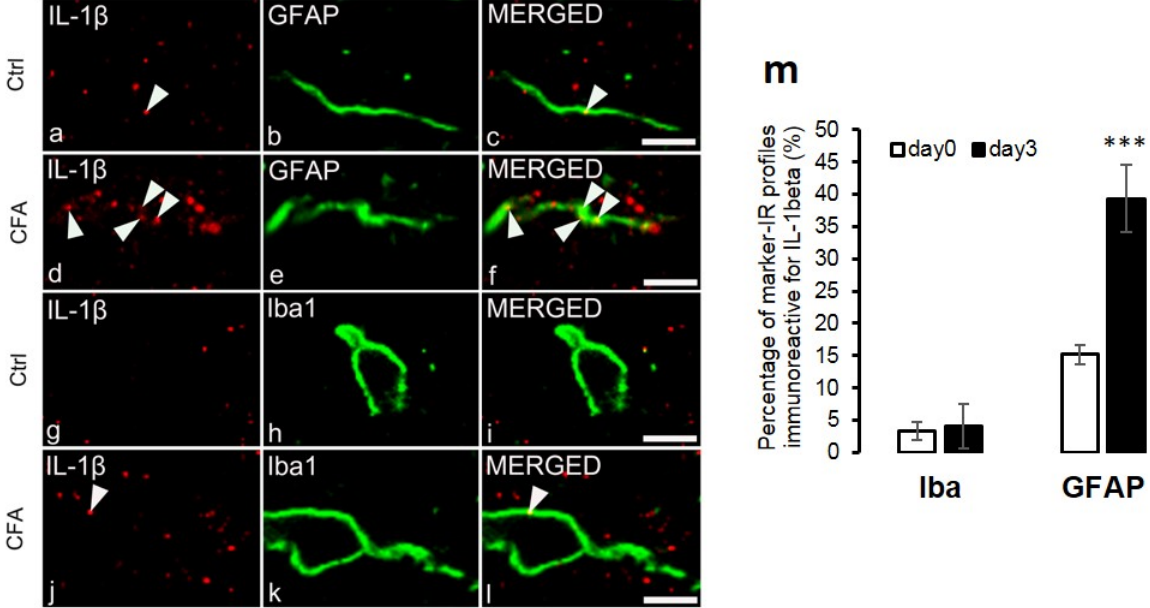
Figure 3. IL-1 β is dominantly expressed by spinal astrocytes on post-injection day 3, at the peak of CFA-evoked inflammatory pain. The figure shows the localization of IL-1 β on glial cells in the superficial spinal dorsal horn of rats. Micrographs of single 1 µ m thick laser scanning confocal optical sections illustrating the co-localization of IL-1 β + puncta (red) with astrocyte (GFAP, green) profiles in control conditions ( a – c ) and in CFA-induced inflammation ( d – f ). Co-localization of IL-1 β + puncta (red) with microglial profiles (Iba1, green) in control ( g – i ) and CFA-induced inflammatory ( j – l ) conditions. Arrowheads on images indicate co-localization. Scale bars: 2 µ m. ( m ) Histogram showing that CFA-evoked inflammation (day 3) significantly increased ( p = 0.002) IL-1 β + immunoreactive spots on astrocytes (GFAP) compared to control (day 0); however, IL-1 β displayed minor co-localization with microglial cells (Iba1). *** p < 0.001.